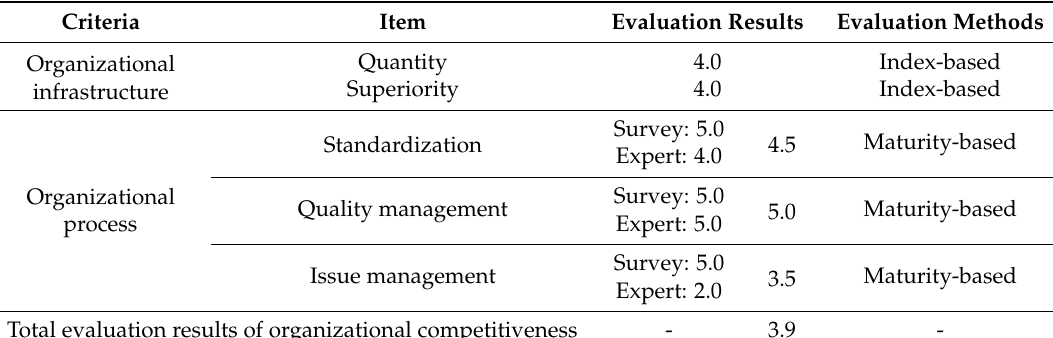
Table 10. Results of analysis on organizational competitiveness—Department